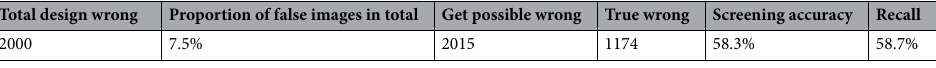
Table 7. Filtering results of external label noise